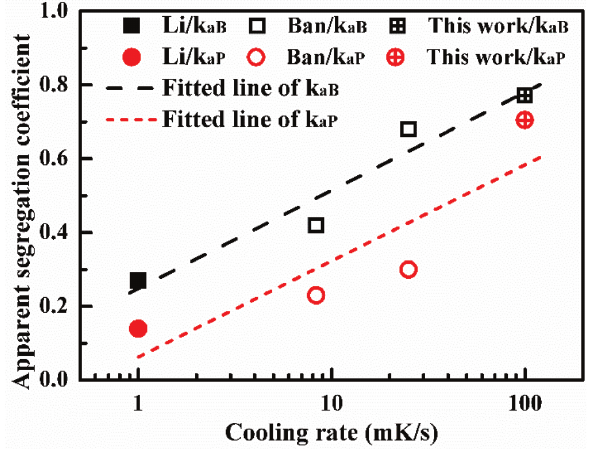
Figure 9: Effect of cooling rate on apparent